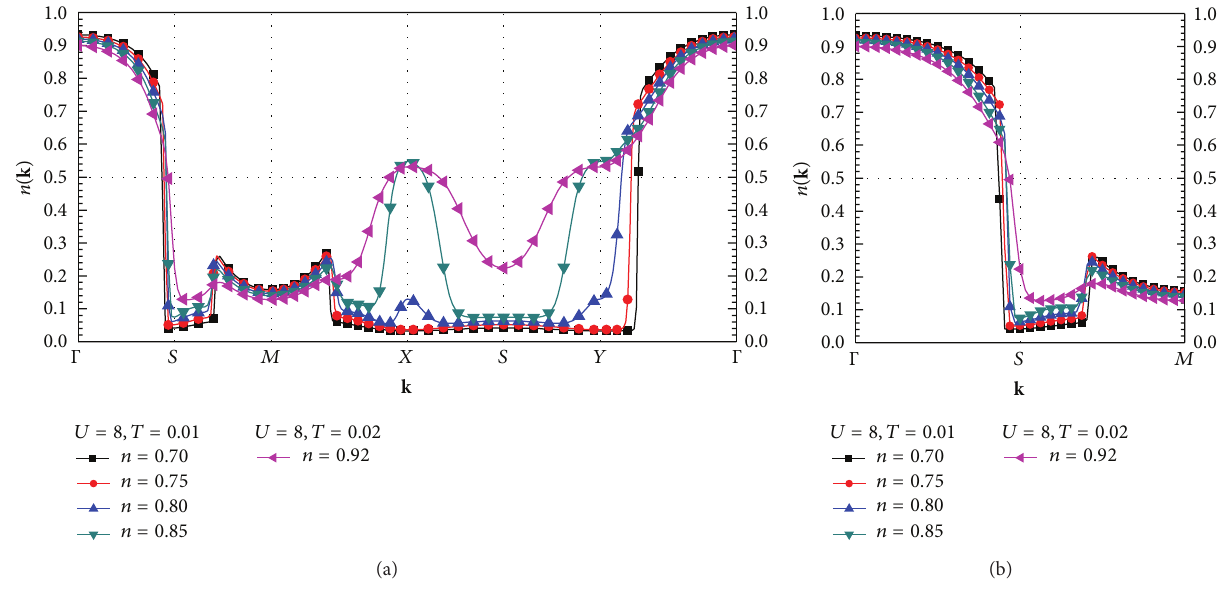
Figure 7: (Color online) Momentum distribution function 𝑛( k ) for 𝑈 = 8 and 𝑛 = 0.7 , 0.75 , 0.8 , 𝑛 = 0.85 ( 𝑇 = 0.01 ), and 𝑛 = 0.92 ( 𝑇 = 0.02 ): (a) along the principal directions ( Γ = (0,0) → 𝑀 = (𝜋,𝜋) , 𝑀 → 𝑋 = (𝜋,0) , 𝑋 → 𝑌 = (0,𝜋) , and 𝑌 → Γ ); (b) along the principal diagonal ( Γ → 𝑀